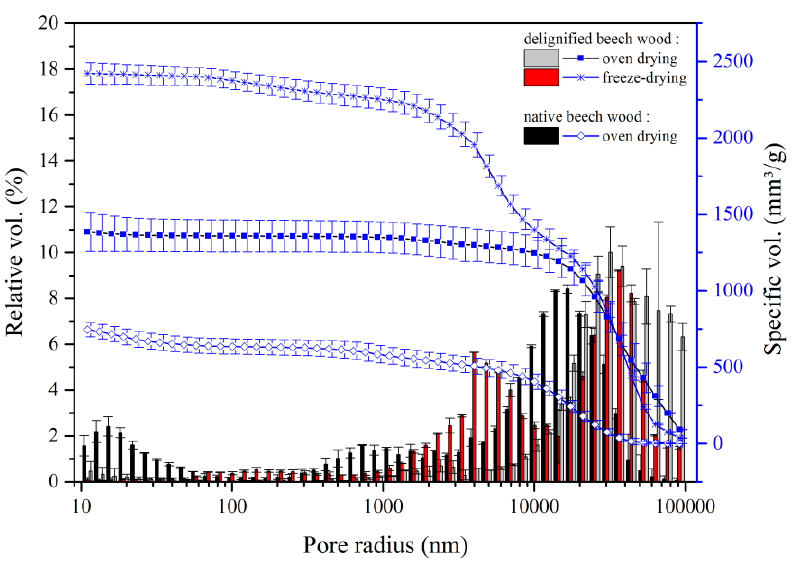
Figure 5. Effect of drying process on porosity of delignified beech wood. Cumulative pore volume and histogram of relative pore volume as a function of the pore radius of native beech, conventionally dried, and delignified wood following the harsh method (80 °C, 4h) dried by freeze-drying and oven dried.